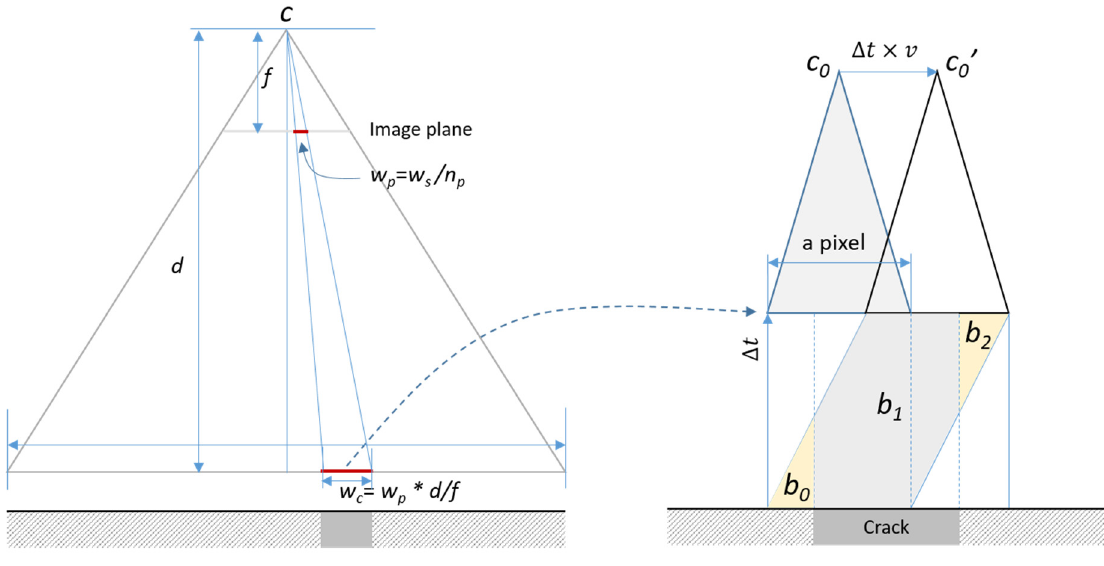
Figure 3. Parameters that control the accuracy of crack measurement.